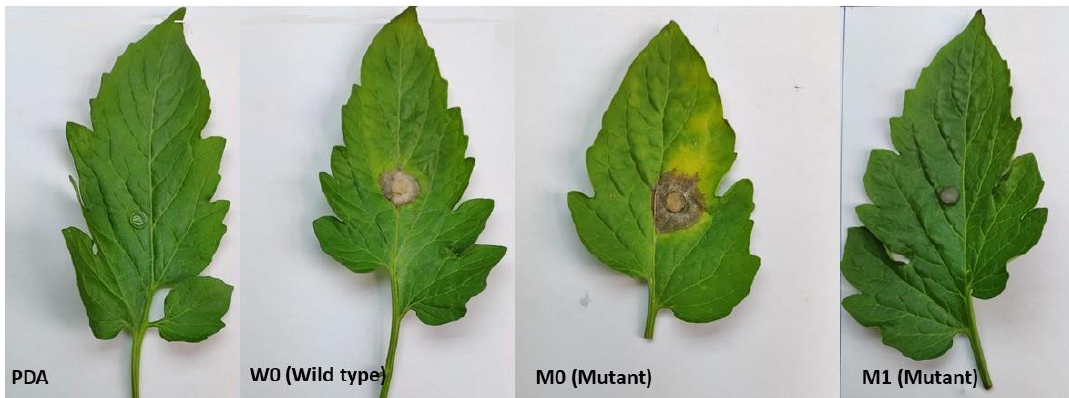
Figure 3. Virulence of B. cinerea Wild type (W0) and its mutnats (M0, M1) on detached tomato leaves after 24 h of inoculation.